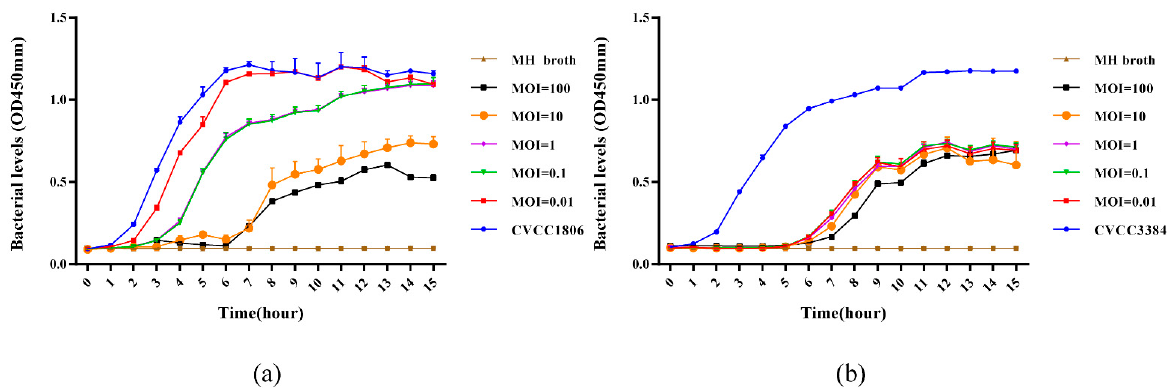
Figure 3. One step growth curves of phages. ( a ) phage PSE-D1. ( b ) phage PST-H1.